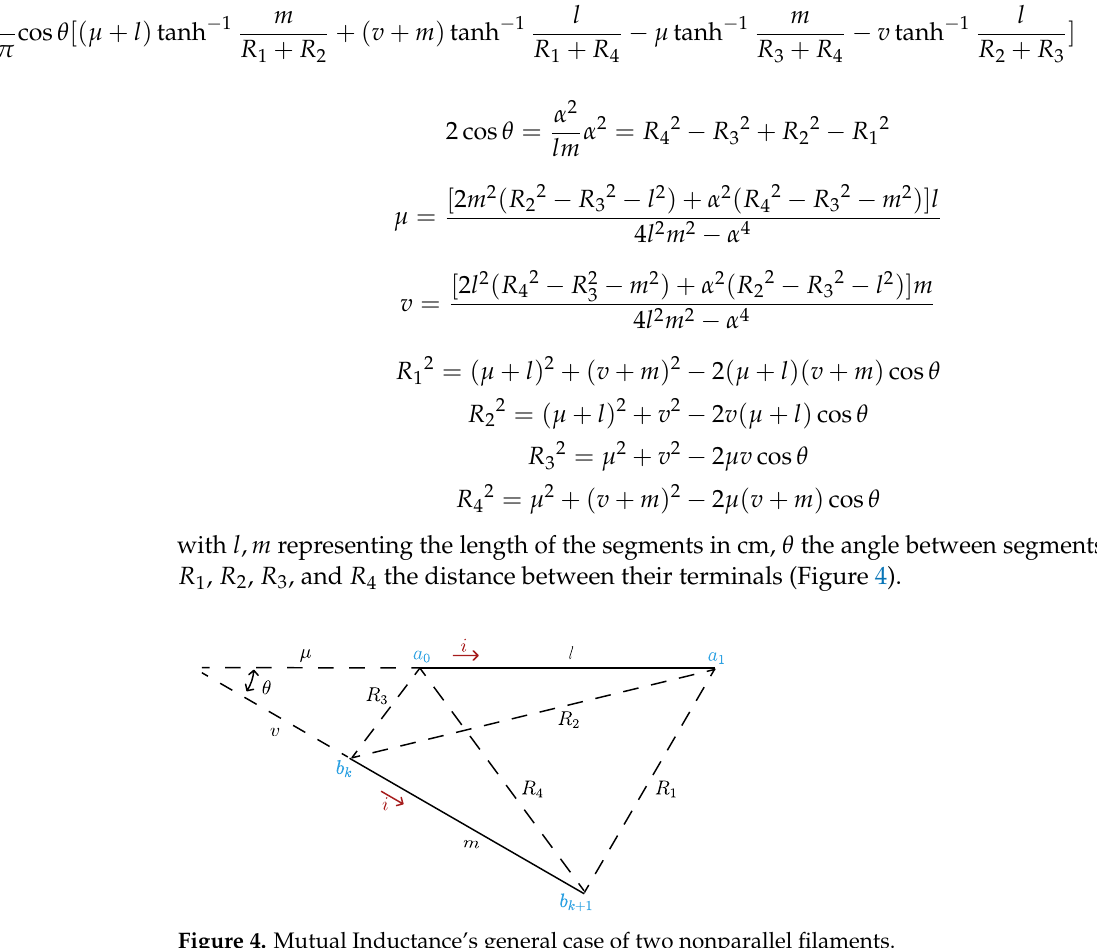
Figure 4. Mutual Inductance’s general case of two nonparallel